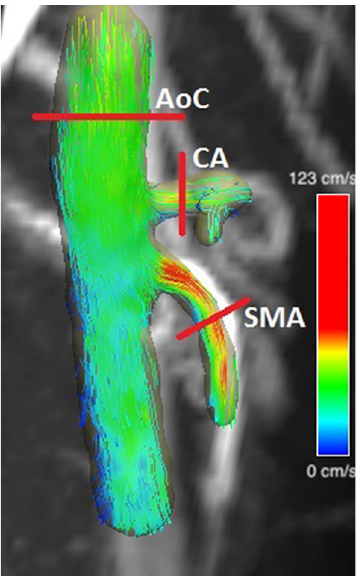
Figure 1. Segmentation of arterial vessels with planes of analysis annotated.